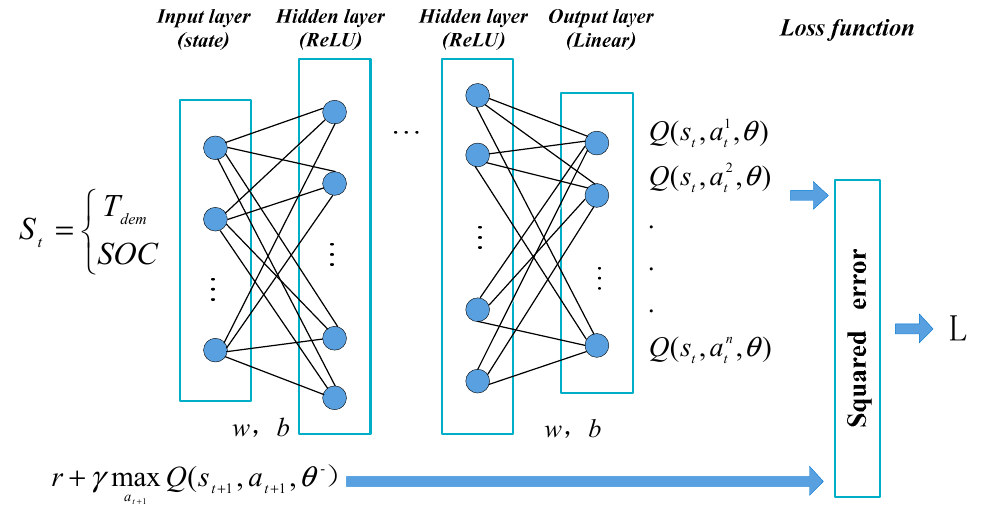
Figure 3. Structure of the neural network.